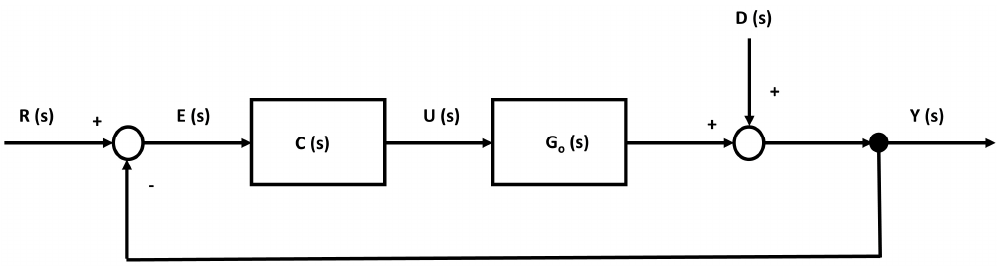
Figure 3. Basic block diagram of a closed-loop control system [63].